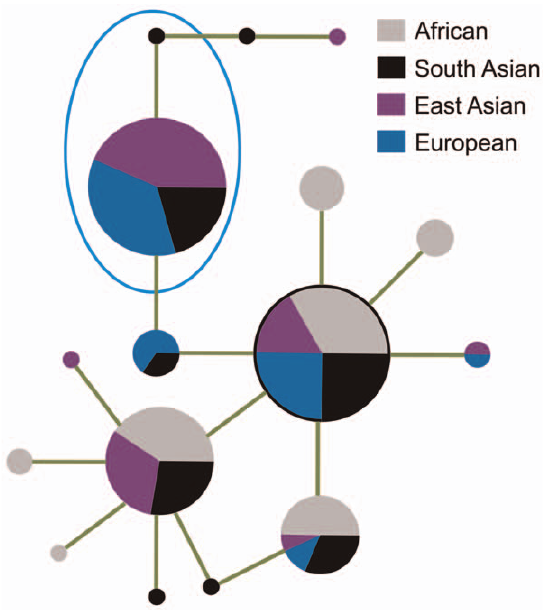
Figure 4. Median-joining phylogenetic network of the 16 haplotypes at at the exon 1 region. Each haplotype is represented by a circle with its area proportional to its frequency. The ancestral haplotype is outlined by a black line. The two haplotypes in the ellipse are the haplotypes that carry the derived allele at SNPs rs143383 and